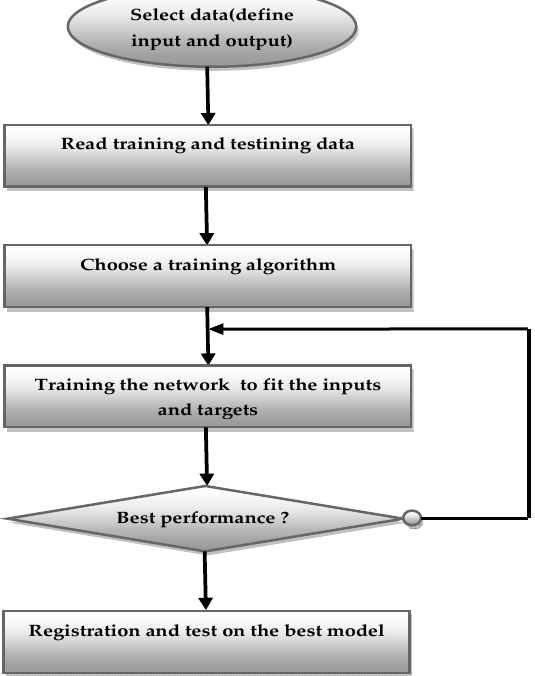
Figure 5. Flowchart of the temperature and solar irradiation prediction algorithm.